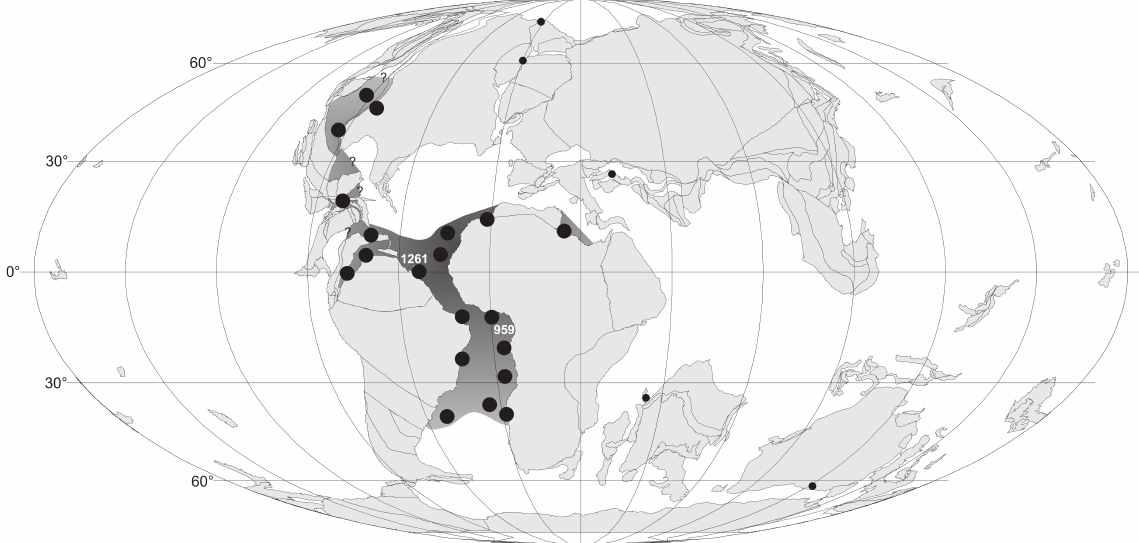
Fig. 1. Plate reconstruction for 86 Ma (around Coniacian–Santonian boundary; modified from Schettino and Scotese, 2002) with area of significant OAE 3 black shale sedimentation marked (large black circles) in the low latitudinal Atlantic and marginal basins and seaways (based on compilations of Wagner et al., 2004; Hofmann and Wagner, 2011; Wagreich, 2009), and other locations with reported local black shales (small black circles). ODP Legs 159 (off Ivory Coast) and 207 (Demerara Rise) with continuous black shales from OAE 2 to Santonian/Lower Campanian are